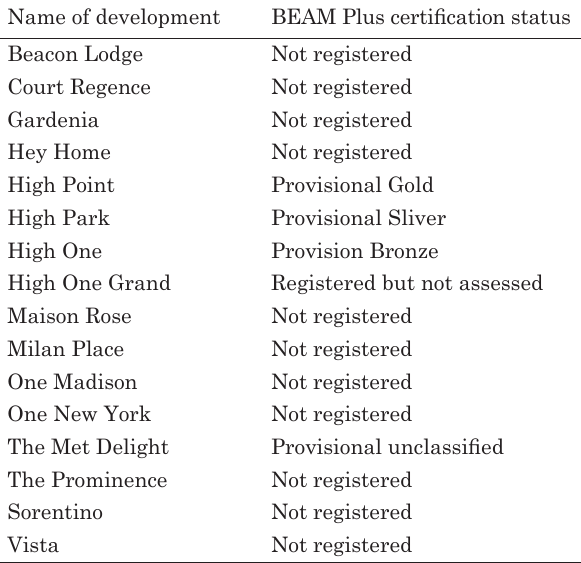
Table 4. Status of the sixteen selected